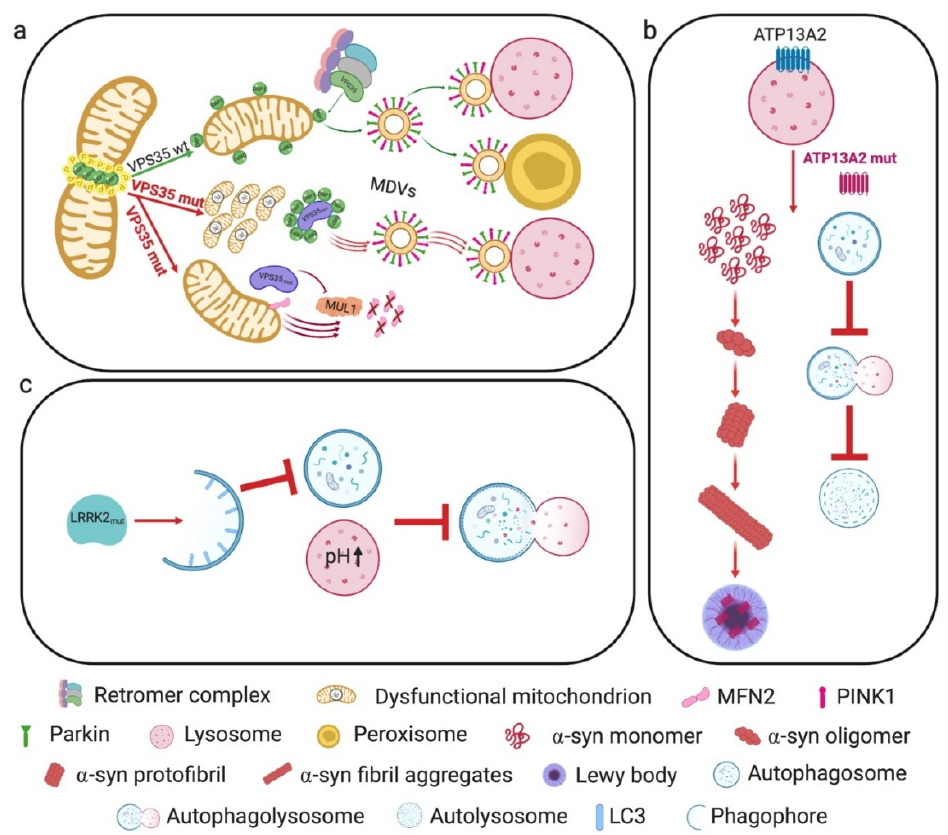
Figure 4. PD-associated genes and their roles in mitochondria-lysosome crosstalk. ( a ) VPS35 is a key component of the retromer complex involved in the removal of DRP1 complexes from mitochondria to lysosomes or peroxisomes through MDVs. Mutant VPS35 enhances turnover of mitochondrial DRP1 complexes through MDVs and lysosomal degradation, accompanied by fragmented and dysfunctional mitochondria. PD-linked VPS35 mutant also leads to increased MUL1-mediated MFN2 degradation. ( b ) ATP13A2 mutations impair the autophagic process, leading to the cytosolic accumulation of α -syn. Sporadic PD patients show decreased levels of this protein, which is also found in Lewy bodies. ( c ) Mutant LRRK2 protein impinges on autophagosome formation, alters lysosomal pH and lysosomal calcium dynamics, resulting in impaired autophagosome–lysosome fusion and lysosome-mediated degradation.